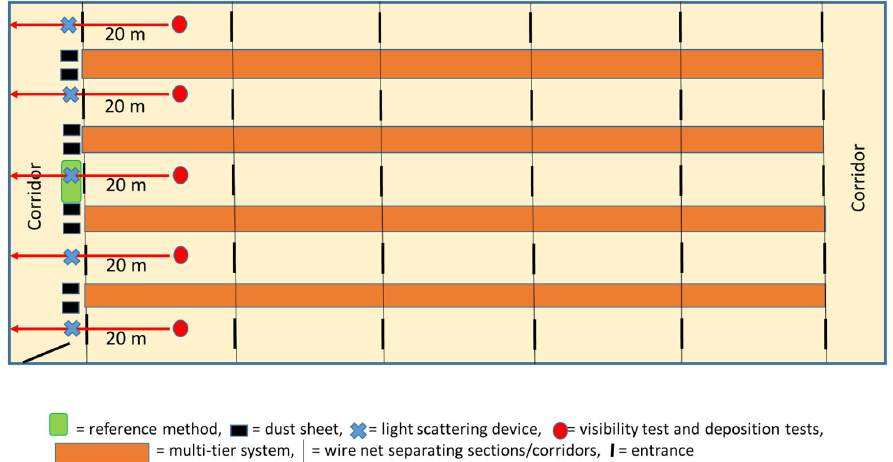
Figure 1. Spots of assessments or measurements in a common barn design.